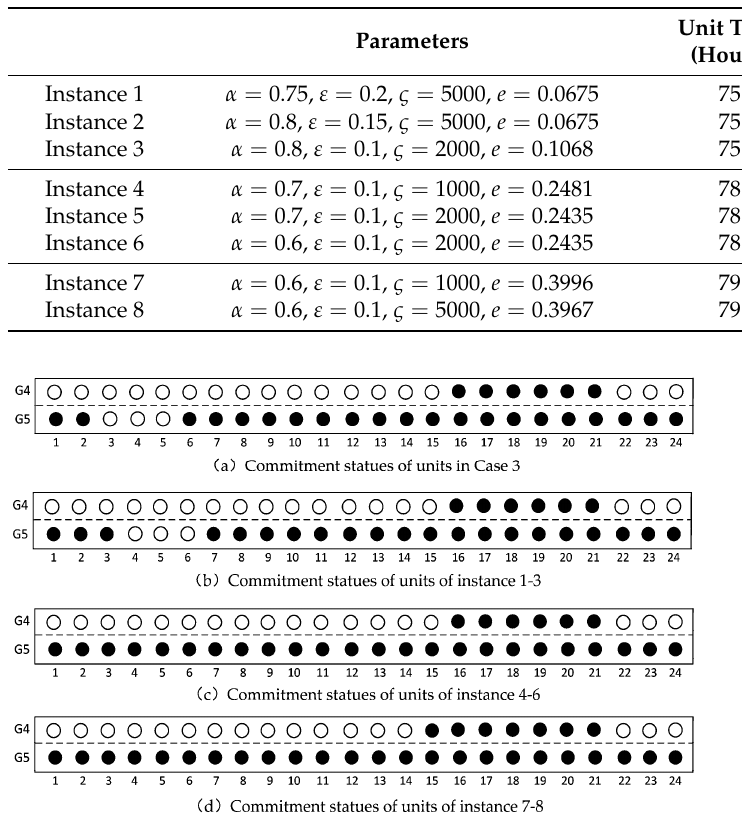
Table 5. System cost in different cases.